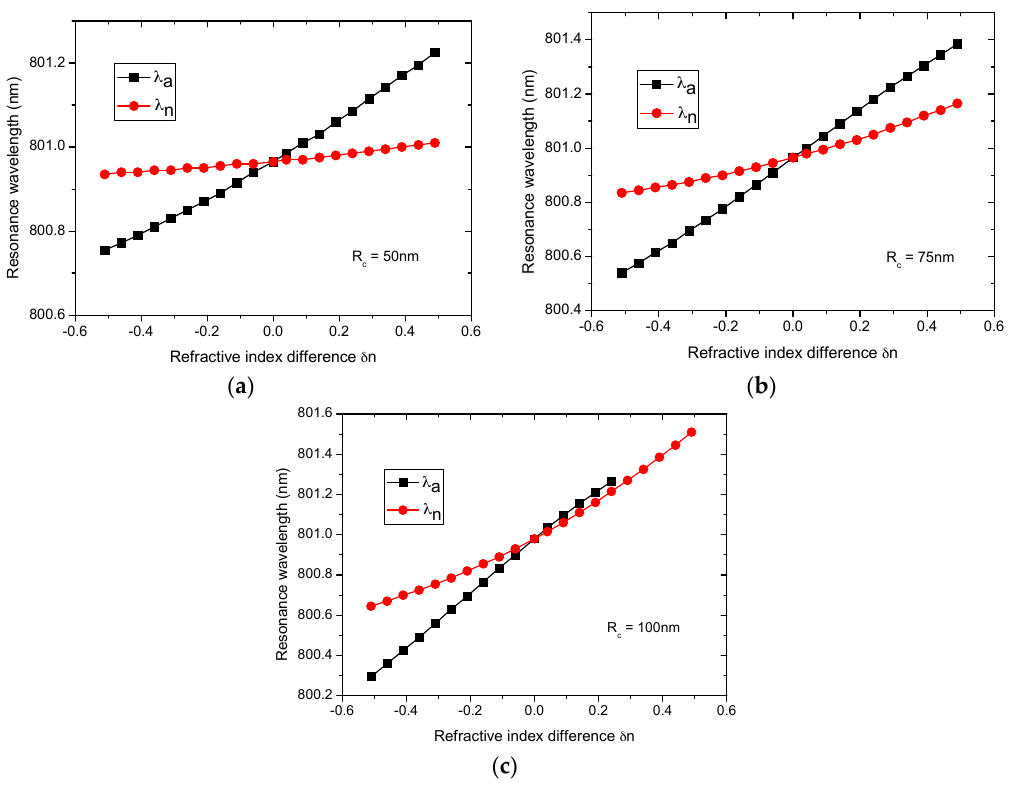
Figure 6. (Color online) Refractive index dependences of the resonance wavelength for ( a ) R c “ 50 nm; ( b ) R c “ 75 nm; and ( c ) R c “ 100 nm. The nanocylinder is embedded at d c “ 4.75 µ m. The reference wavelength of the unperturbed WGM is λ o “ 800.966 nm.